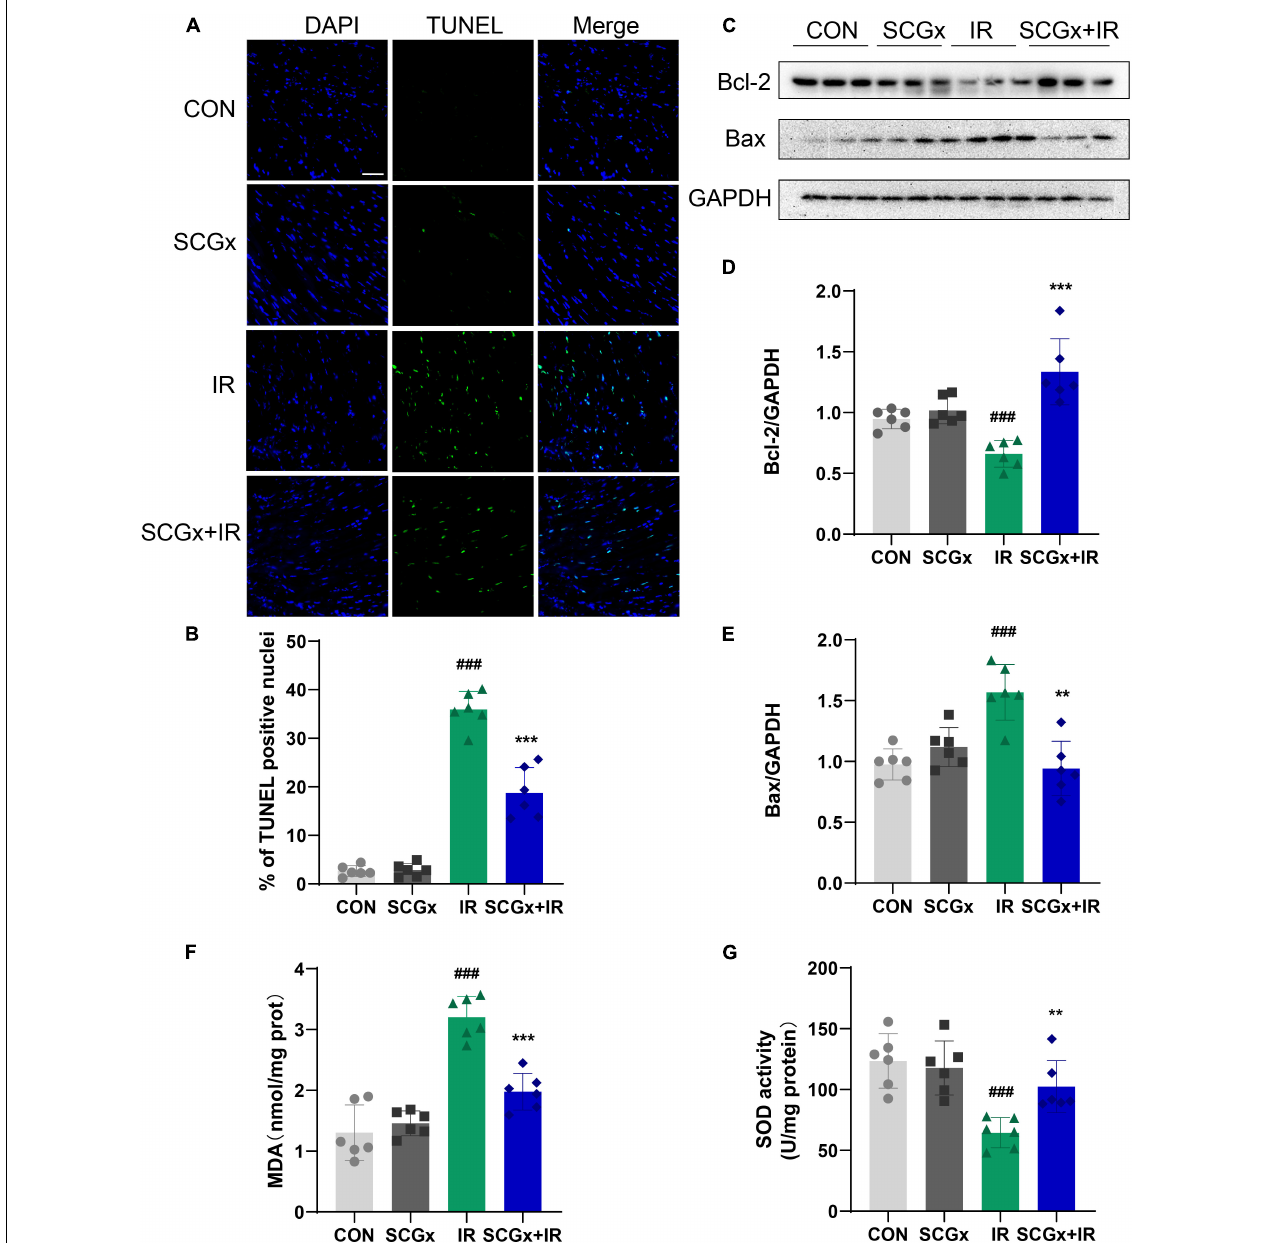
FIGURE 3 | The level of apoptotic cells and oxidative stress decreased upon sympathetic denervation. (A) Cell apoptosis was detected via TUNEL. scale bar: 50 µ m. (B) Percentage of TUNEL positive nuclei in each group. (C–E) The expression of Bcl-2 and Bax in heart tissue. (F,G) Detection of SOD and MDA in heart tissue. n = 6, 0.001 < ** P < 0.01 and *** P < 0.001 compared with the I/R group. ### P < 0.001 compared with the CON